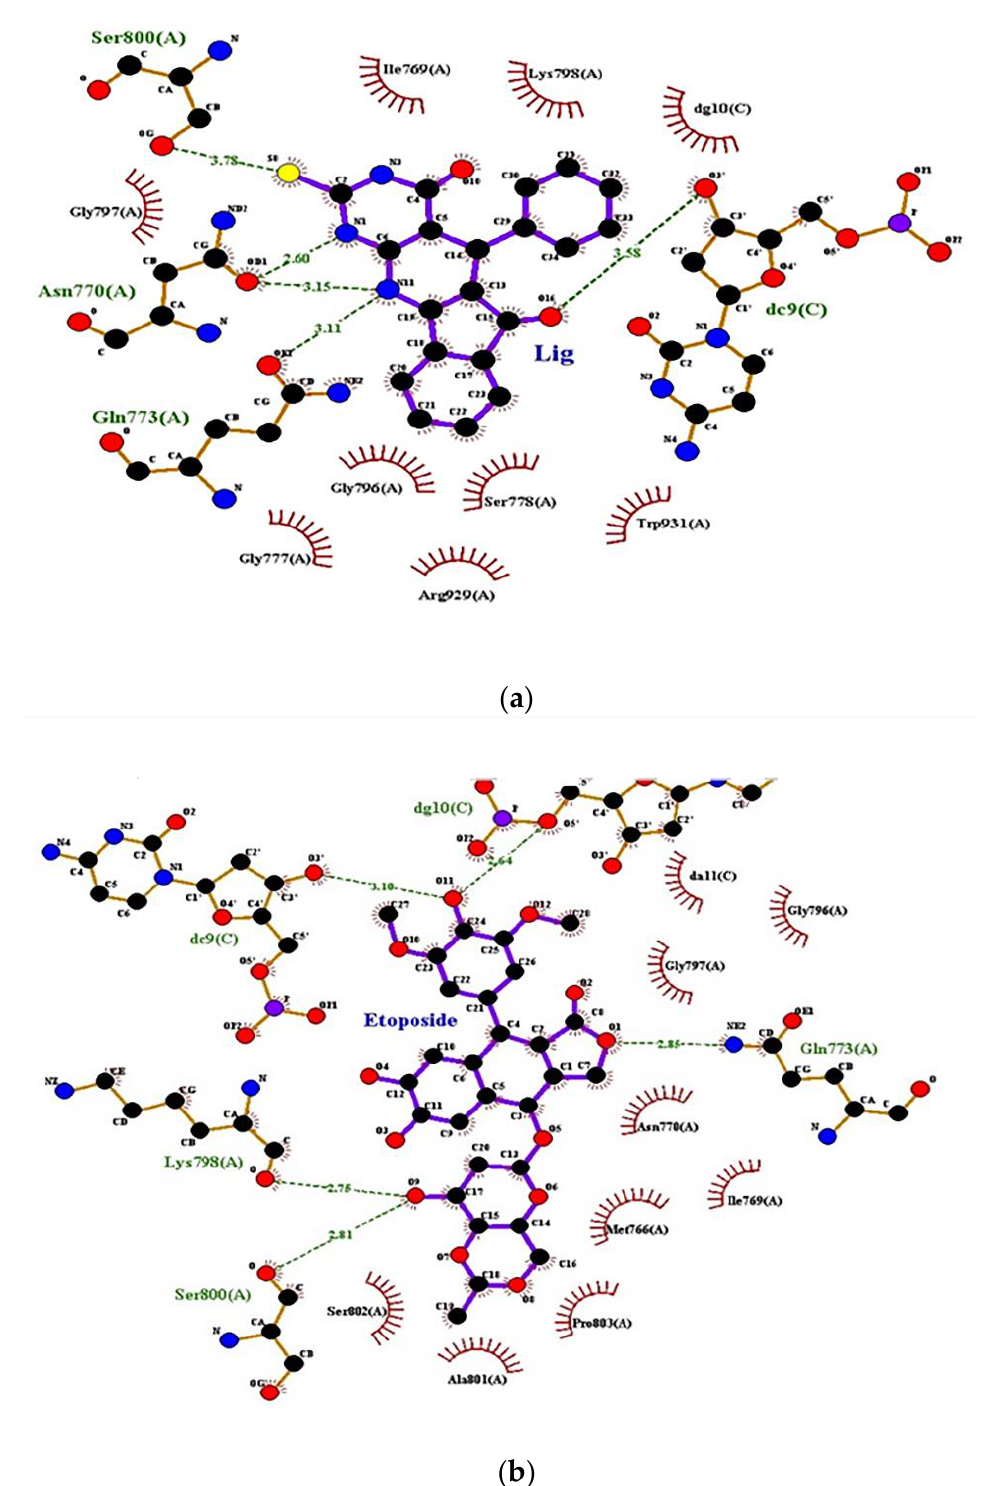
Figure 4. ( a ) Binding sites of the 2H compound of TUDHIPP with human DNA topoisomerase IIα, 4fm9. ( b ) Binding sites and interaction of etoposide with human DNA topoisomerase IIa, 4fm9.